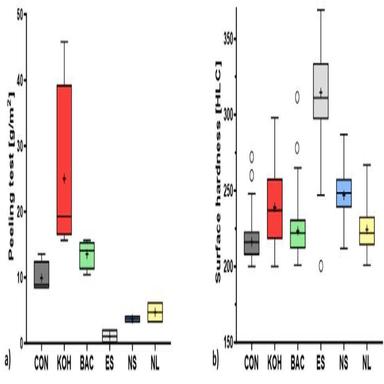
Boxplots summarizing weight loss (g/m2 ) based on peeling test results (a) and surface hardness (b) of untreated (CON) and treated earthen mock-ups. (Each box extends from 25th to 75th percentiles, whiskers indicate lower/higher absolute values, central line and cross indicate median and average values, respectively. Empty circles indicate outliers).